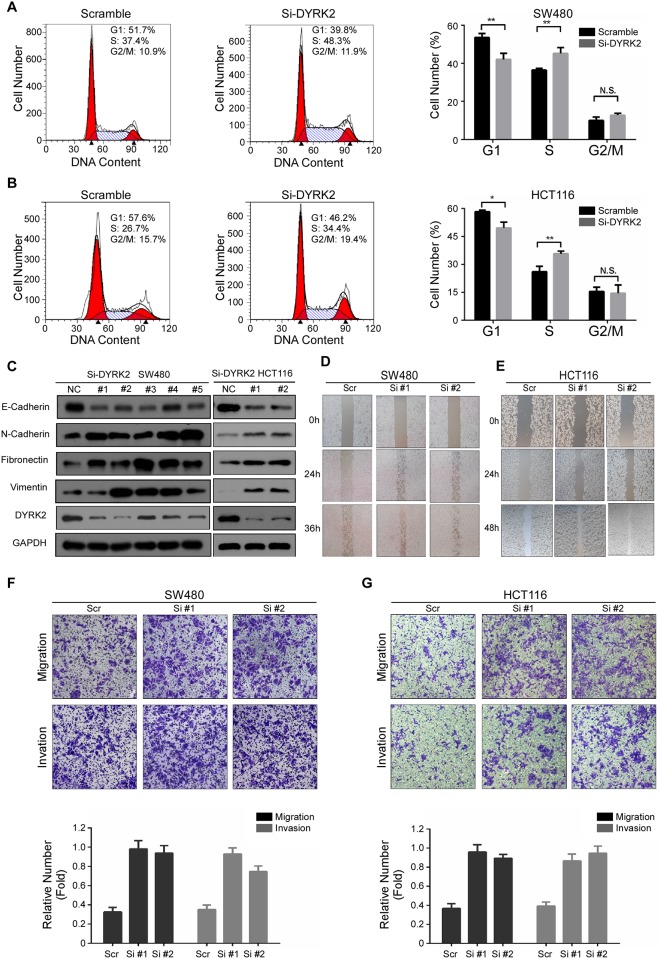
DYRK2 inhibits the proliferation, cell migration and invasion of colorectal cancer cells in vitro.A, B: The effect of DYRK2 depletion on the cell cycle. Experiments were performed in triplicate. C: Western blot analysis of E-cadherin, N-cadherin, Fibronectin and Vimentin expression in the indicated treatment of the CRC cell lines. D, E: The cell's ability of wound gap closure was dramatically enhanced by knocking down DYRK2 both in HCT116 and SW480 cells. F, G: Migratory and invasive abilities of the indicated cell lines in vitro was measured by the Transwell assay as described in “Materials and methods”. Bars correspond to mean+ standard error, with a P value calculated by using Student’s t-test. *P<0.05, **P<0.001.